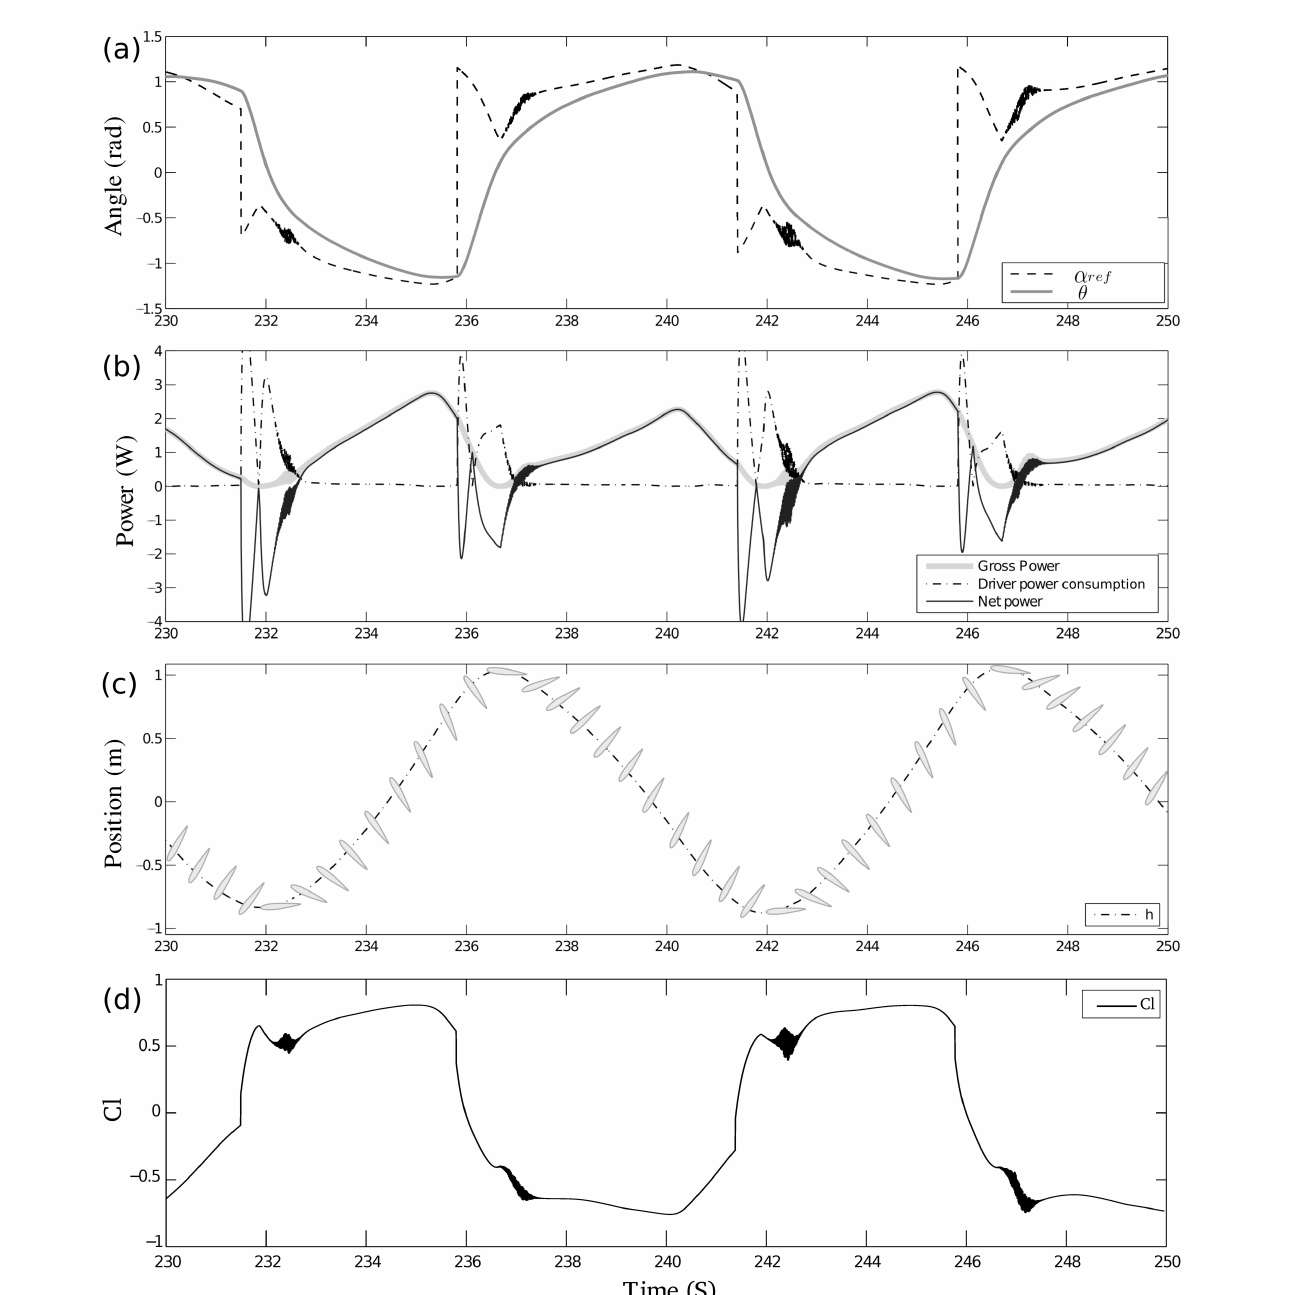
Figure 5. System response behavior. h 0 / c = 2.5, B = 0.375. From top to bottom: ( a ) Reference tracking. ( b ) Power output and energy consumption. ( c ) Position of the rotation center of the foil. ( d ) Lift Coefficient C L